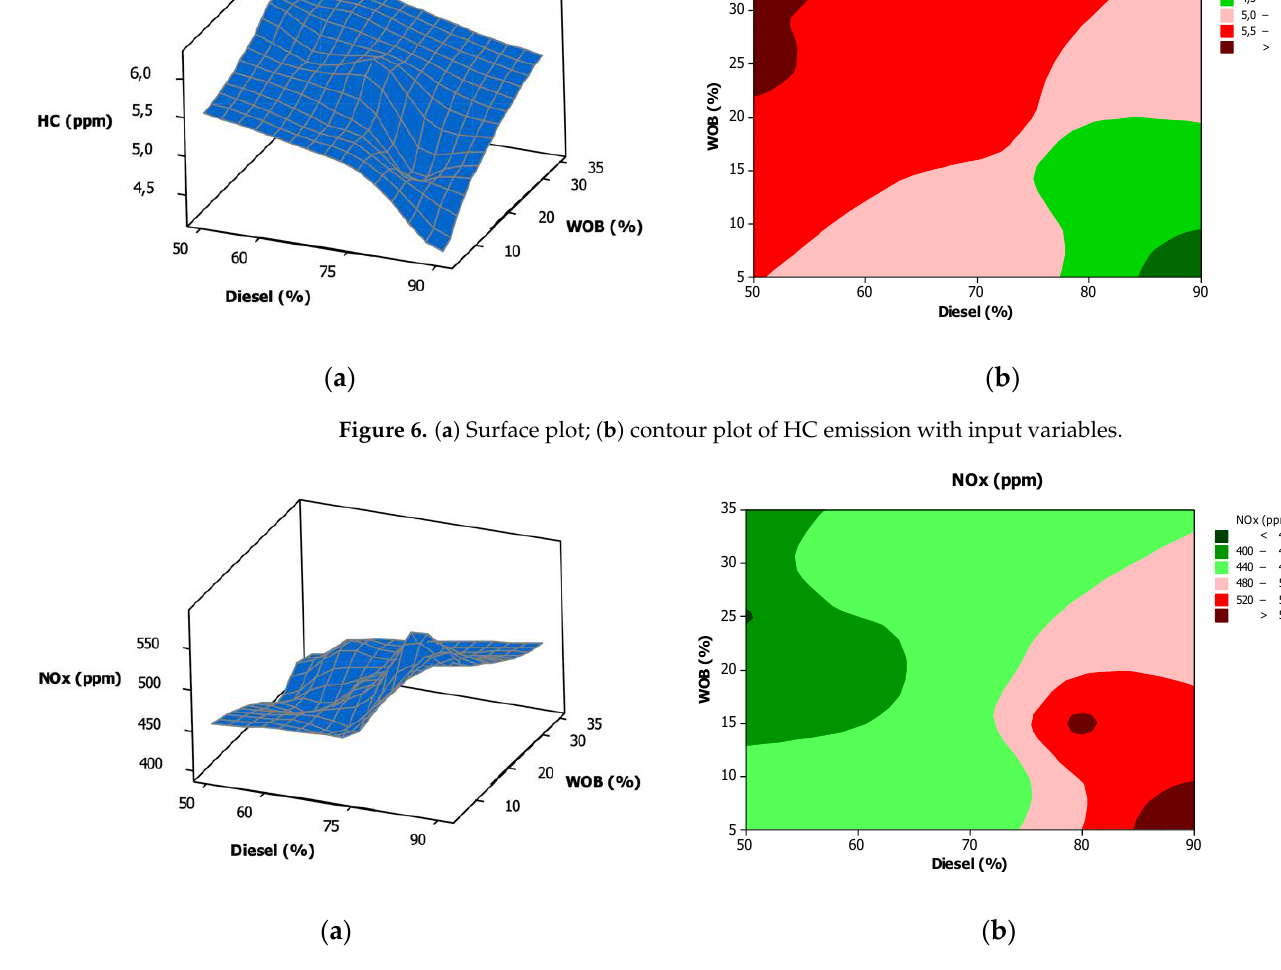
x emission with input